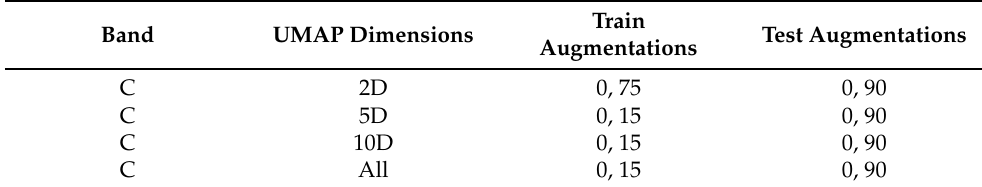
Table 4. Training augmentation sets chosen using different latent space representations (UMAP Dimension) for the C-band study. Training augmentations are selected based on the smallest Maha- lanobis distance between the 90 ◦ rotated images and every other augmentation set. The All UMAP Dimension uses a combination of distances from the 2D, 5D, and 10D latent